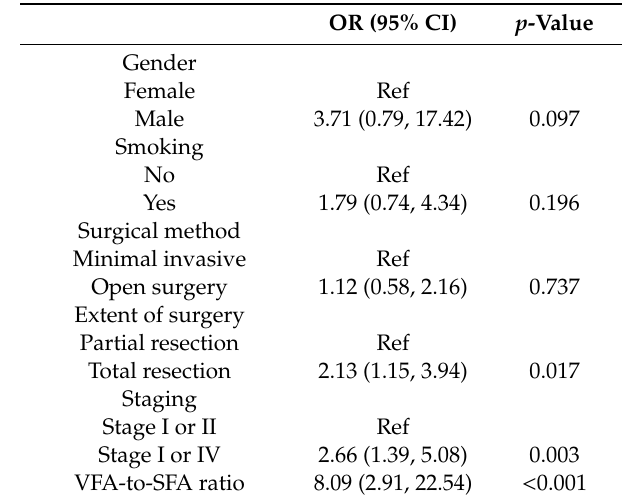
Table 2. Multivariate logistic regression analysis * to identify independent risk factors for surgical site infection after gastrectomy.